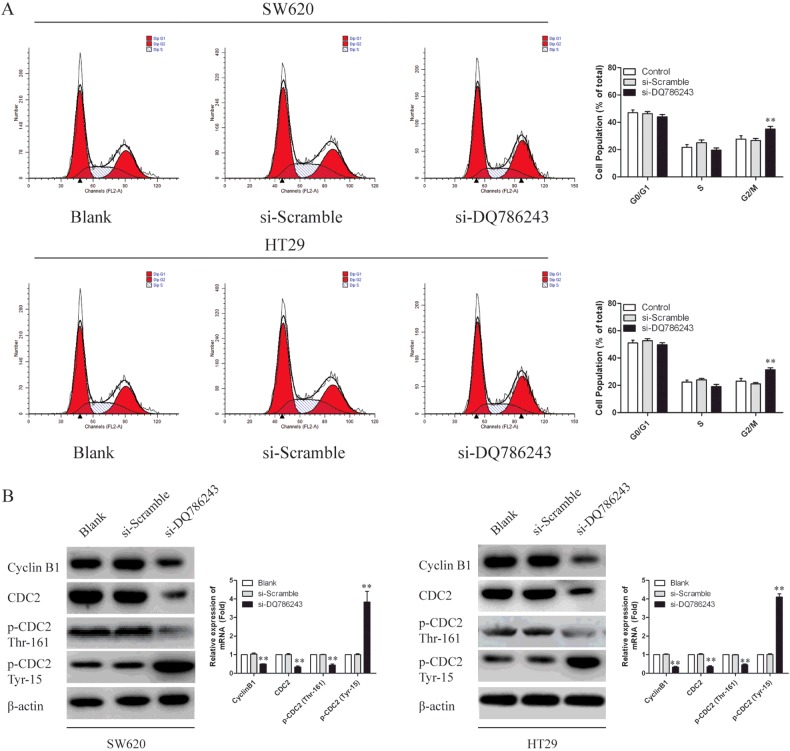
LncRNA DQ786243 regulated cell cycle progression in SW620 and HT29 cells(A) A cell cycle analysis was performed using FCM. Representative histograms were presented. Depletion of DQ786243 decreased the percentage of cells in S-phase and increased that in G2/M- phase in both SW620 and HT29 cells. All the results shown are representative of three independent experiments, **P<0.01. (B) Immunoblotting assays were performed to examine certain cell cycle-related proteins in SW620 and HT29 cells transfected with si-DQ786243 or si-Scramble.